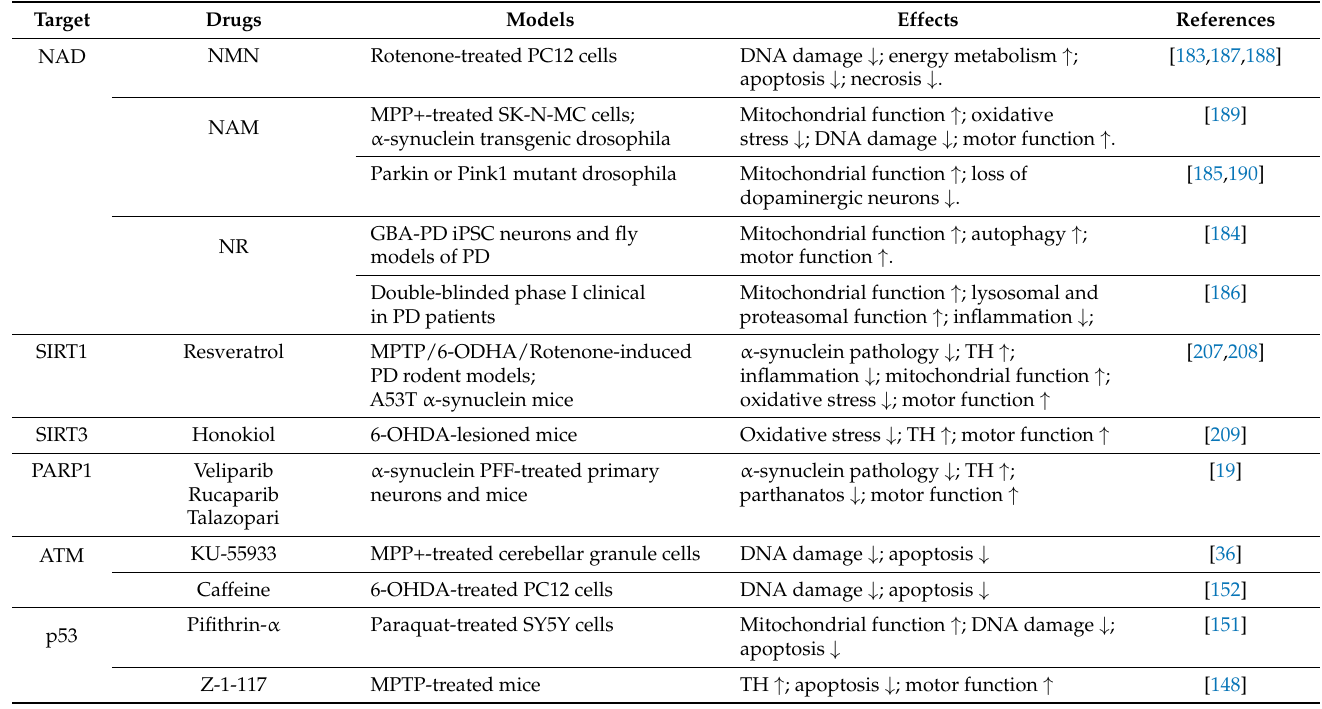
Table 1. The application of drugs targeting DNA repair or DDR in the treatment of